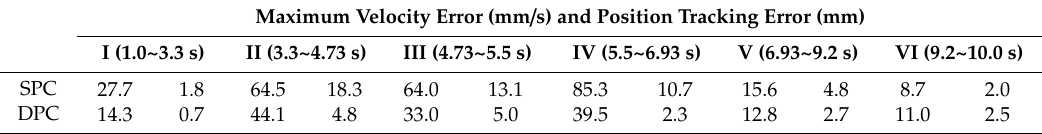
Figure 11. Tracking performance comparison of the SPC and DPC: ( a ) position tracking and velocity fluctuation, ( b ) position tracking error. Table 4. Maximum velocity error and position tracking error of the SPC and DPC in each